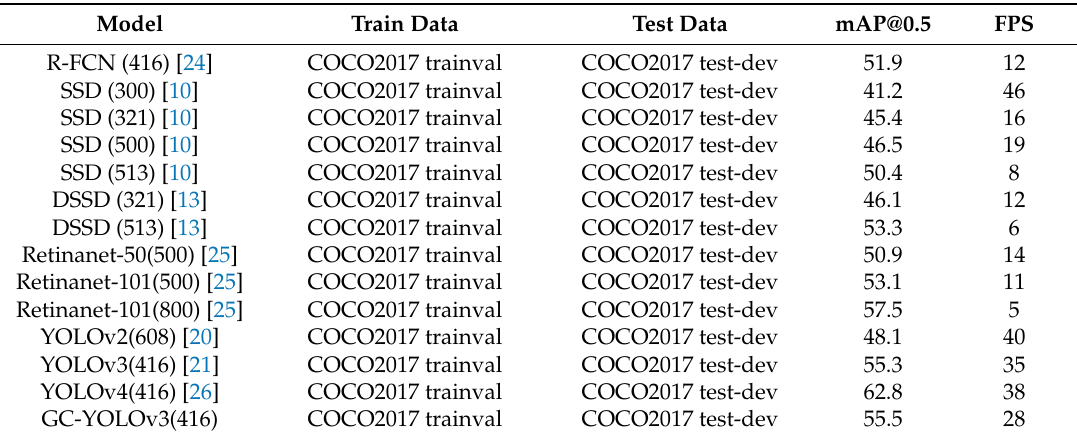
Table 6. COCO2017 test-dev detection